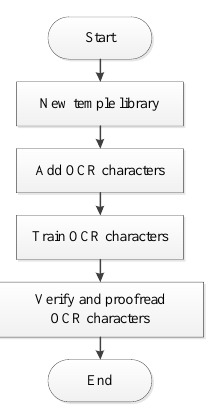
Figure 14. Design flow chart of license plate recognition.